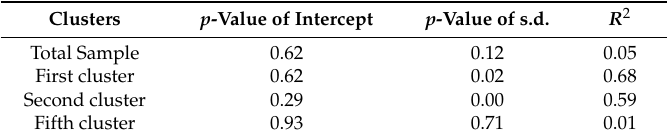
Table 3. Descriptive statistics of daily linear regressions. Clusters